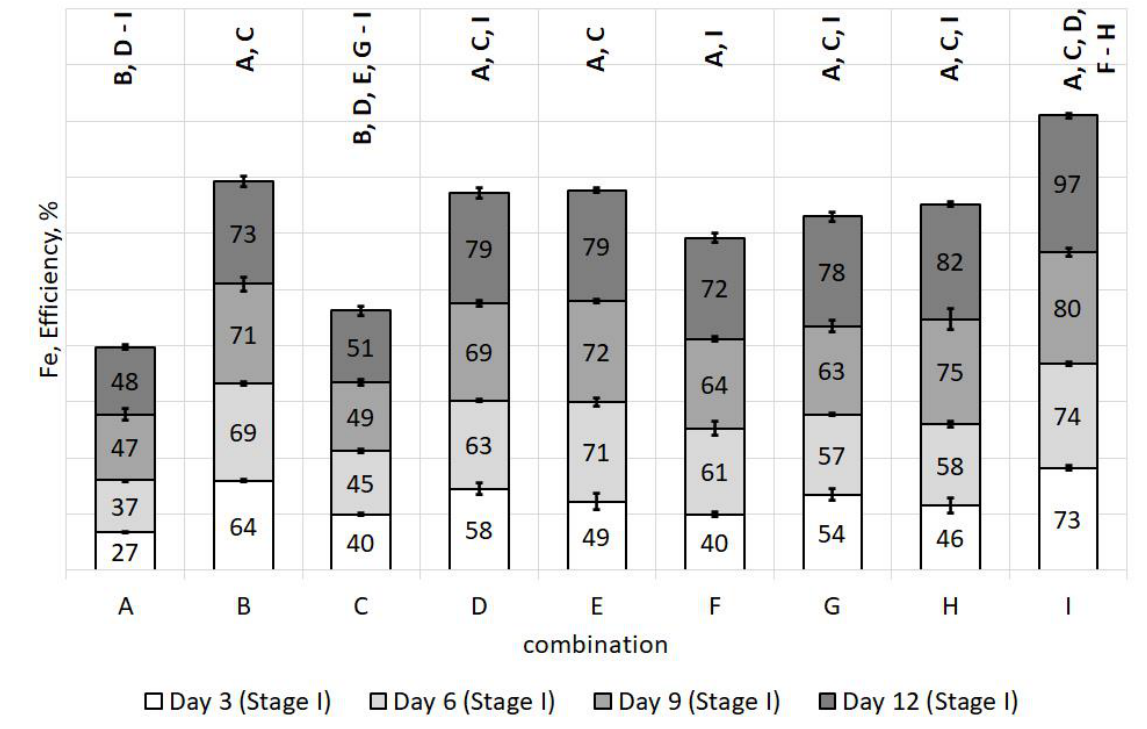
Figure 13. Effectiveness of Fe release to the dissolved fraction of leachate (Stage I).